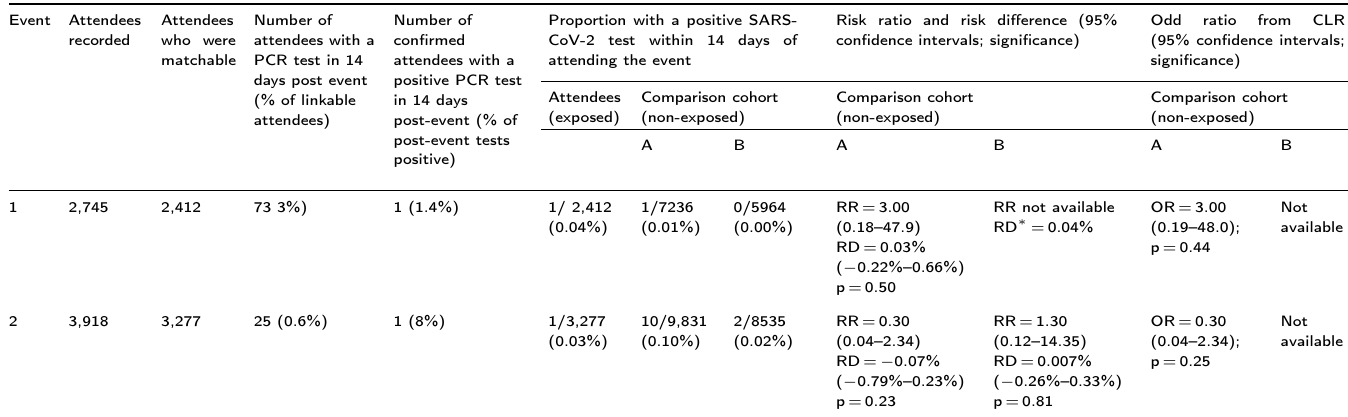
Table 2: Numbers of linkable attendees, proportions of positive SARS-CoV-2 test in exposed and non-exposed groups and associated risk ratios following each event